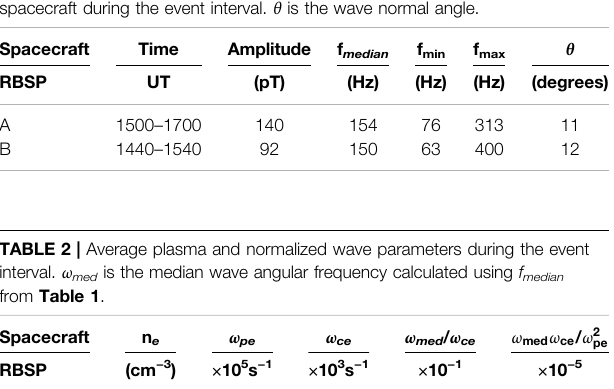
FIGURE5| Bounce averaged diffusioncoef fi cient (1/s,log10 scale) with respect to energy (E) and equatorial pitch angle ( α ) at L (cid:1) 5.9 for the